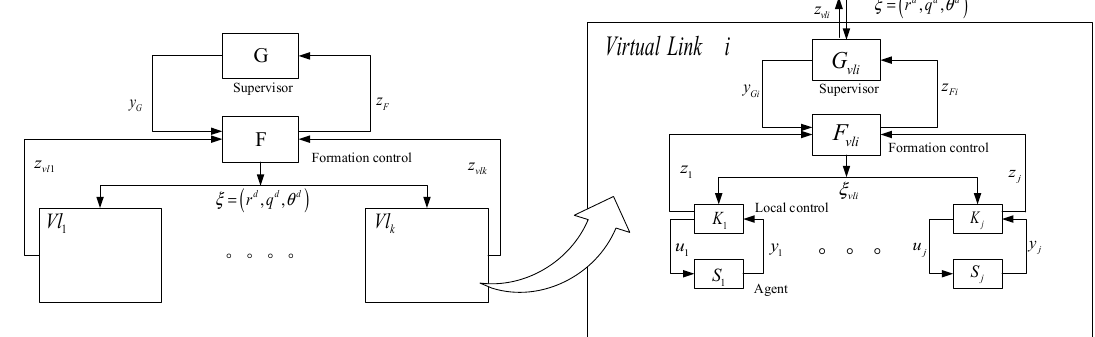
Figure 2. Hierarchical architecture of the previous virtual